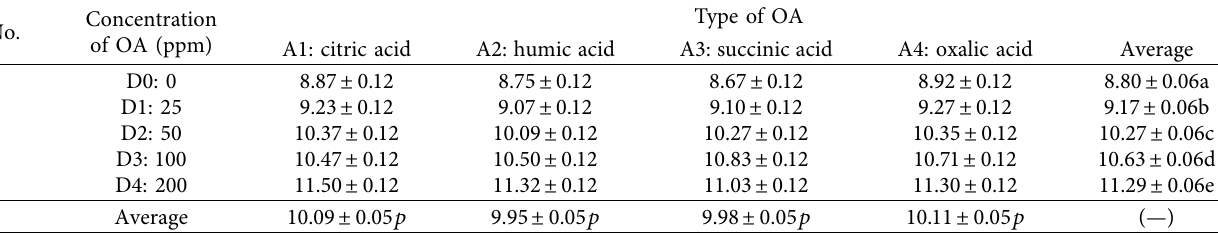
Table 7: Efect of OAs application on available P average from 4 observation